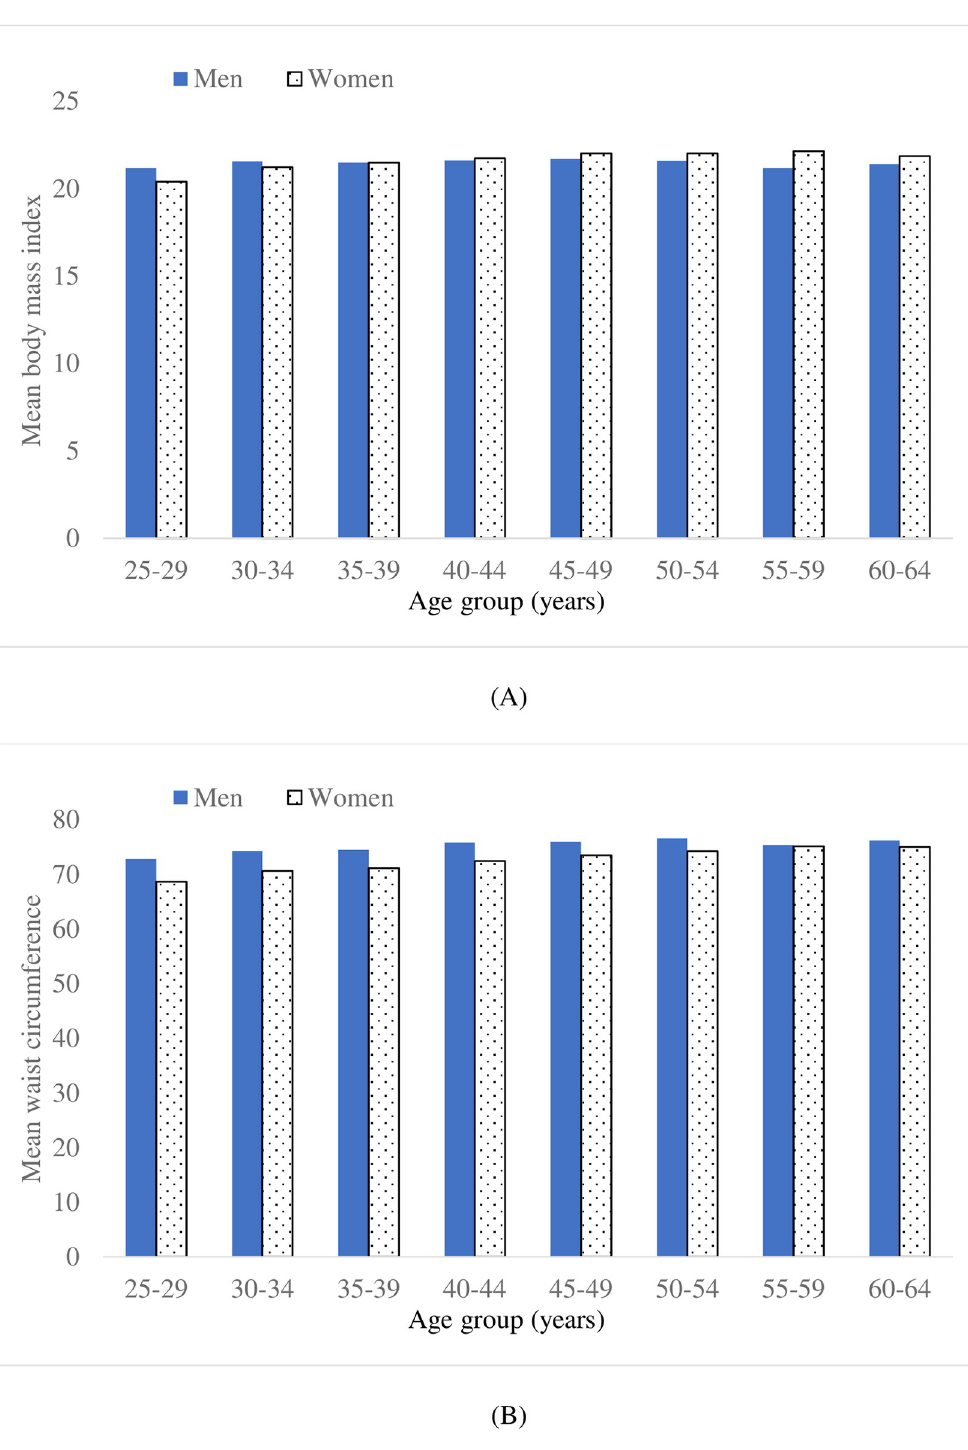
PLOS ONE | https://doi.org/10.1371/journal.pone.0256589 August 20,